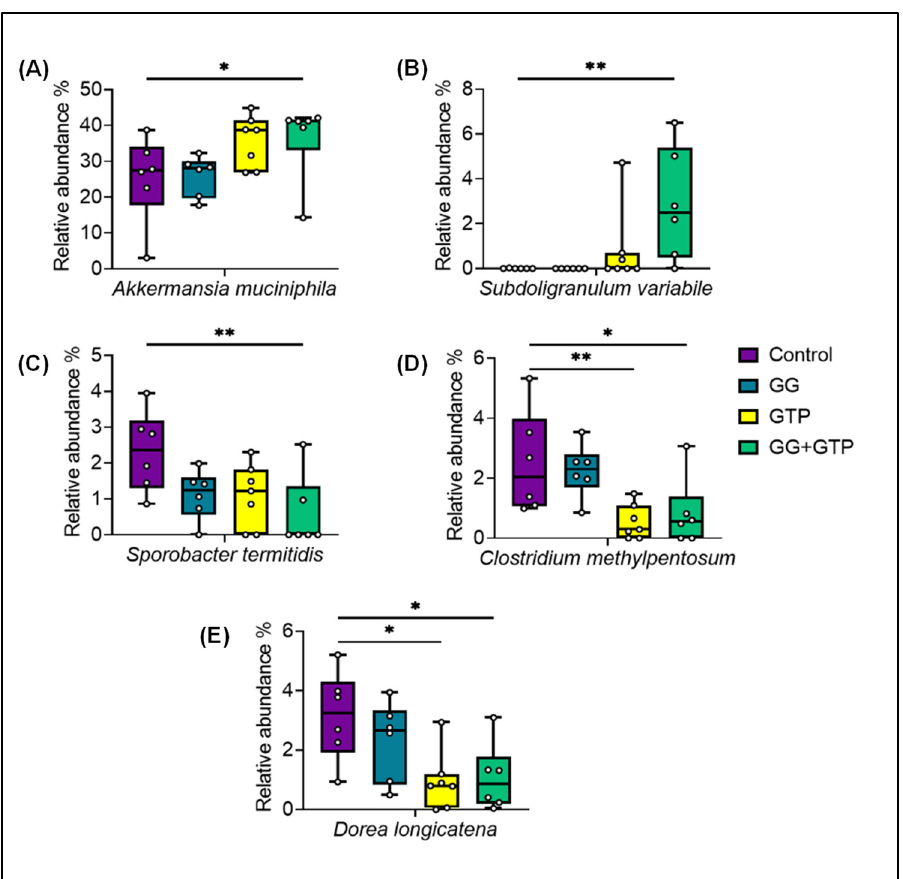
Figure 6. Amplicon sequence variants (ASVs) with a statistically significant differential abundance of ( A ) Akkermansia muciniphila , ( B ) Subdoligranulum variabile , ( C ) Sporobacter termitidi , ( D ) Clostridium methylpentosum, and ( E ) Dorea longicatena among diet groups. Control, HFD only; GG, HFD supple- mented with GGOH in 400 mg/kg diet; GTPs, HFD supplemented with 0.5% weight/volume GTPs in water; GG + GTPs, HFD supplemented with a combination of GGOH and GTPs. * p < 0.05 and ** p < 0.01. Kruskal–Wallis test was performed followed by Dunn’s test.